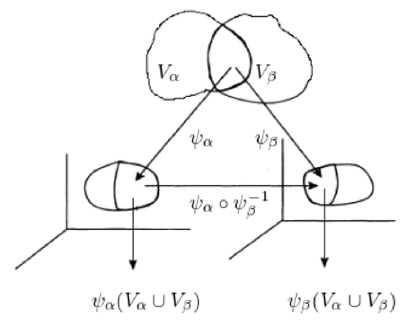
Figure 1. Transition